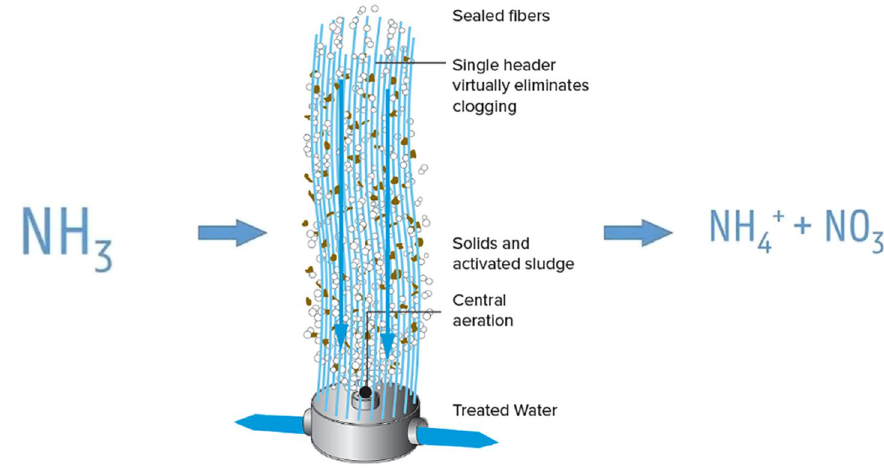
Fig. 14 A schematic detail of the membraned aerated biofilm reactor with its chemi- cal reaction is carried out in compartment